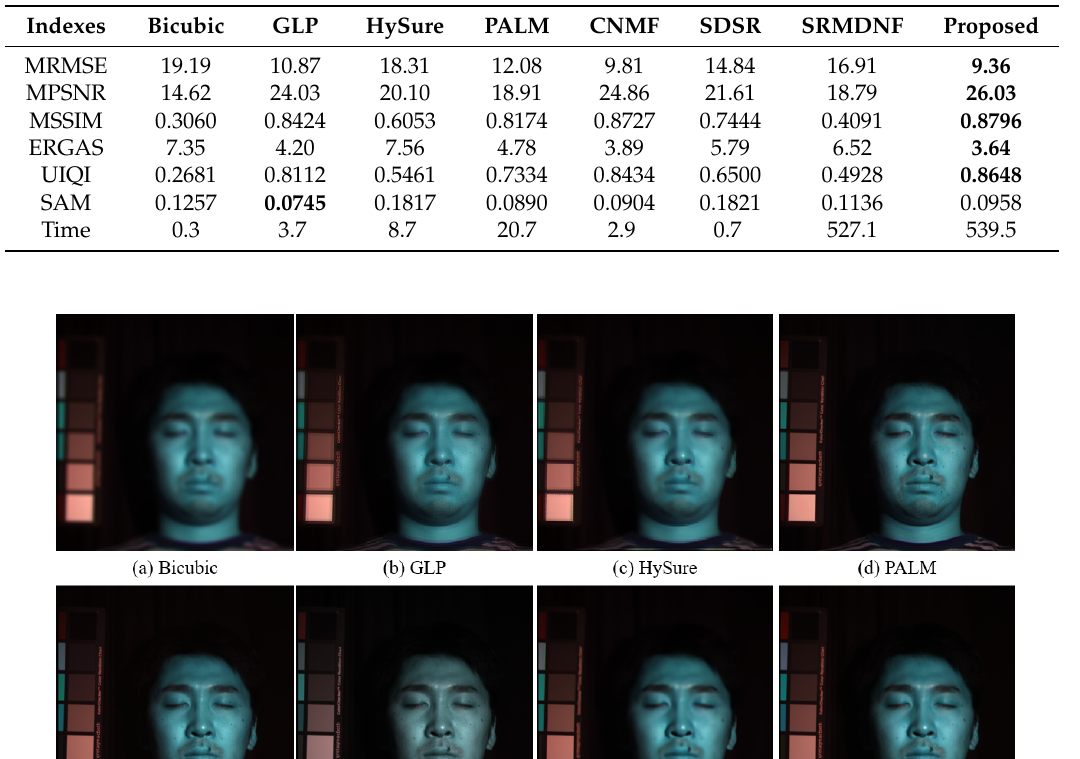
Table 8. Quantitative results on the Paris dataset with a magnification factor of 4.